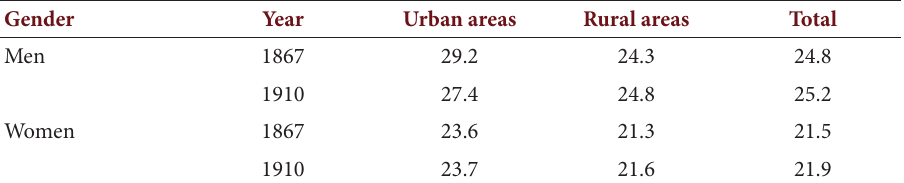
Table 6. Average age at marriage in European Russia in 1867 and 1910, (years) Gender Year Urban areas